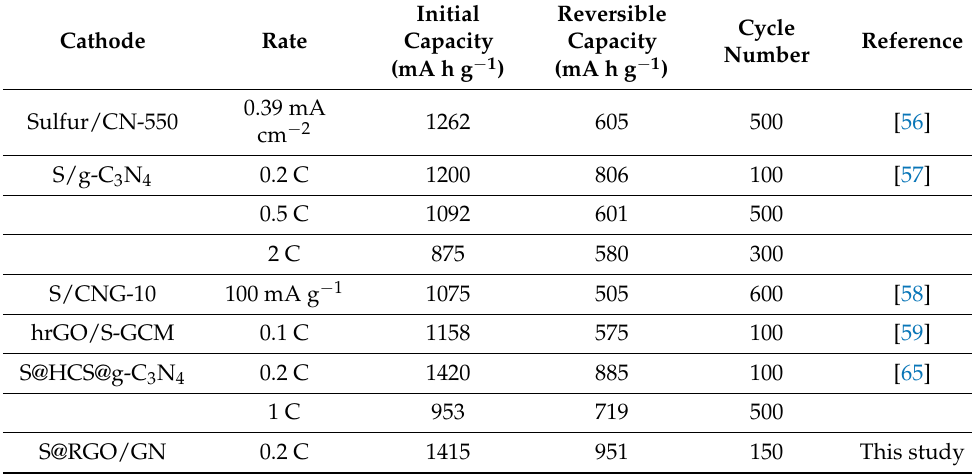
Table 3. Comparison between the performance of S@RGO/GN and other cathode nanocomposites that utilized g-C 3 N 4 in their structure